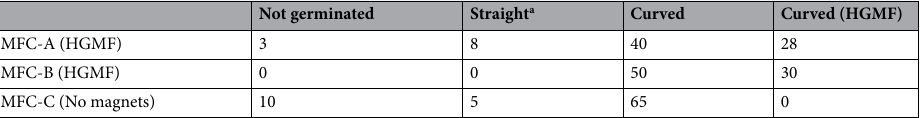
Table 2. Germination and curvature in the presence and absence of HGMFs of a total of 80 seeds per MFC. a Refers to roots that never emerged from the seed cassette or were too short to reach the HGMF area (as shown in Fig. 2).